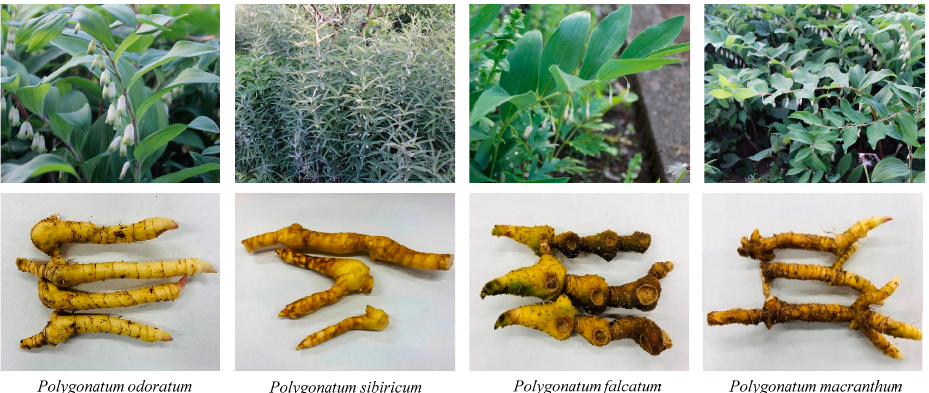
Figure 5. Photographs of plants from genus Polygonatum .